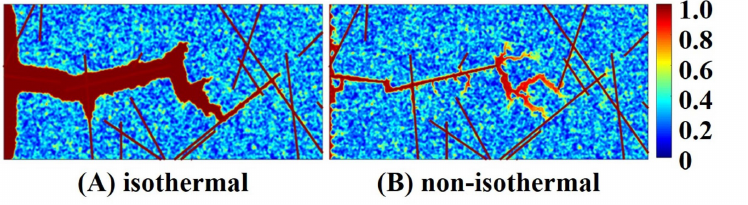
Figure 8. Comparison of dissolution structures for non-isothermal and isothermal cases in linear acidizing simulation.